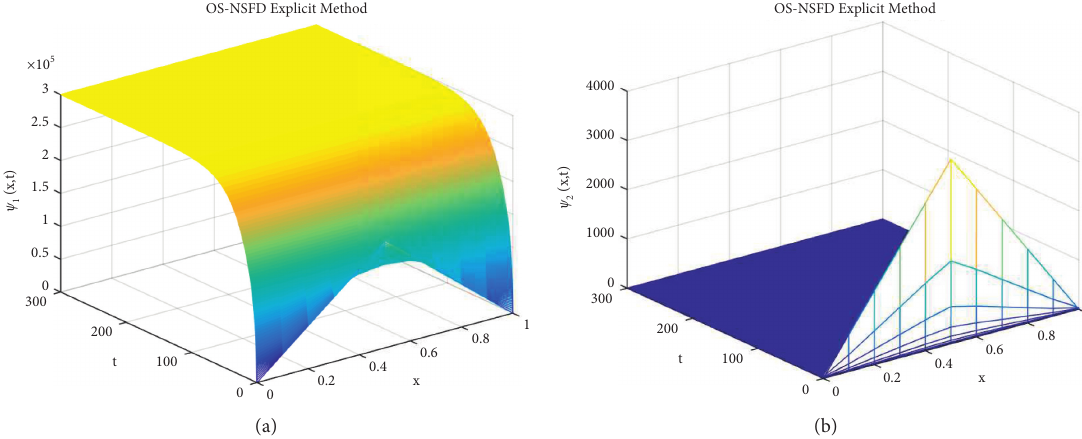
Figure 12: Solution graphs of ψ � λ � 0 . 05. (a) Solution graph of ψ κ � 0 . 1 , λ 1 2